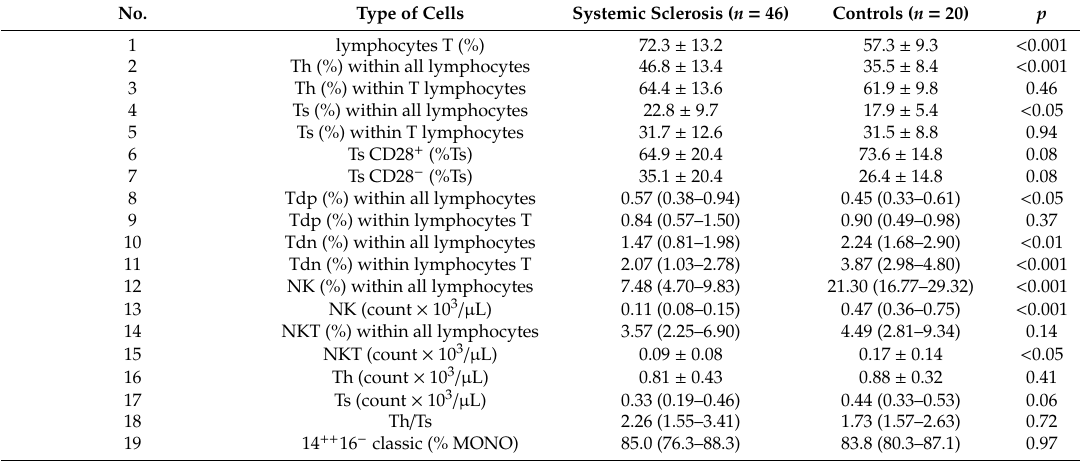
Table 2. Main immunocompetent cells in patients with systemic sclerosis and healthy